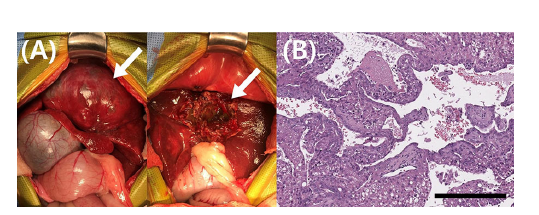
FIGURE2 Gross morphological and histopathological findings of the liver mass in a dog with combined hepatocellular- cholangiocarcinoma. (A) During surgery, these pictures were taken before and after the partial hepatectomy. Complete excision of the liver mass was impossible because of significant adhesion to diaphragm. The mass (arrow) was excised as much as possible but about 10% of the mass (arrow) remained unresected. (B) Histopathology of the hepatic mass revealed that the hepatic parenchyma includes two overlapping proliferations. One section comprised tubules, cysts, and epithelial cell nests in fibrovascular stroma. The neoplastic cells had variably distinct cell borders, moderate amount of eosinophilic cytoplasm, and oval nuclei. Marked anisokaryosis and anisocytosis were observed with two mitotic figures in 10 high-power fields (400 × ). The second section comprised a hepatocellular neoplasm. Two to four hepatocyte-wide hepatic cords were observed, with loss of lobular architecture. Hepatocytes had abundant cytoplasm with central to peripheralized nuclei. Mild anisokaryosis and anisocytosis were observed with 12 mitotic figures in 10 high power fields (400 × ). Magnification 400 × ; scale bar = 50 µ m. H&E, hematoxylin &